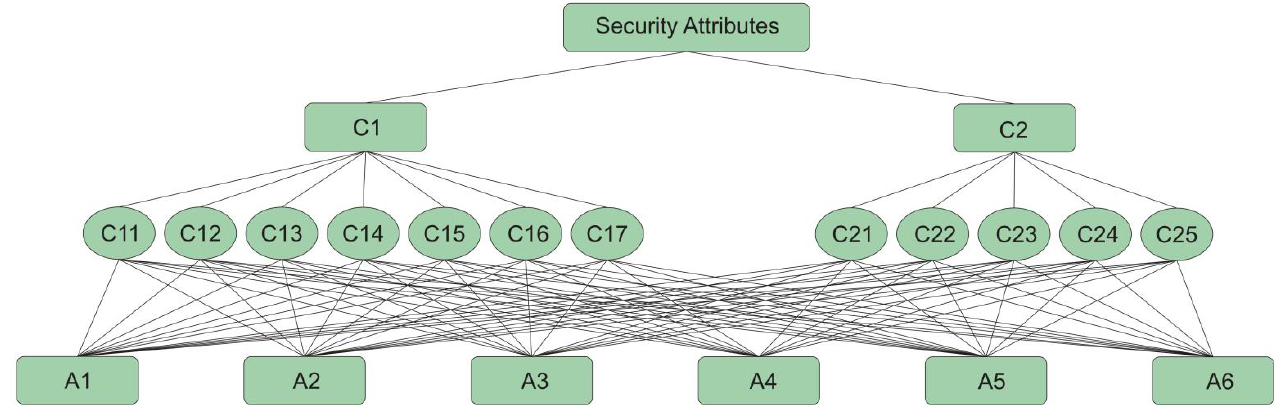
Figure 6. A tree structure of security parameters .